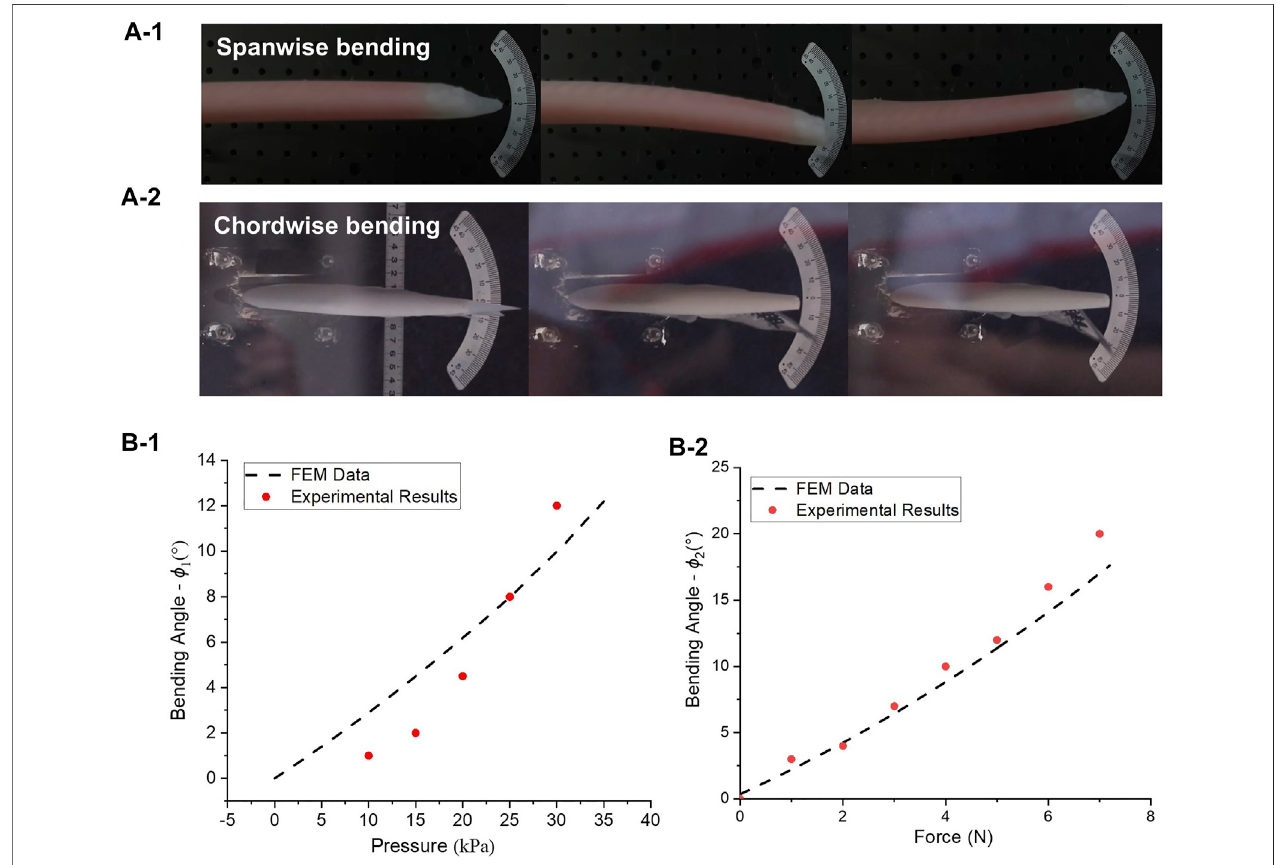
FIGURE 7 | Experiments and FEM validation. (A-1) Spanwise de fl ection of morphing wings under pressure; (A-2) Chordwise de fl ection of morphing wings under force; (B-1) Comparison of spanwise de fl ection between FEM and experimental results under pressure control in a pneumatic spar; (B-2) Comparison of chordwise de fl ection between FEM and experimental results under force control in a pantographic rib (Red dots: experimental data, black dashed curves: FEM results).